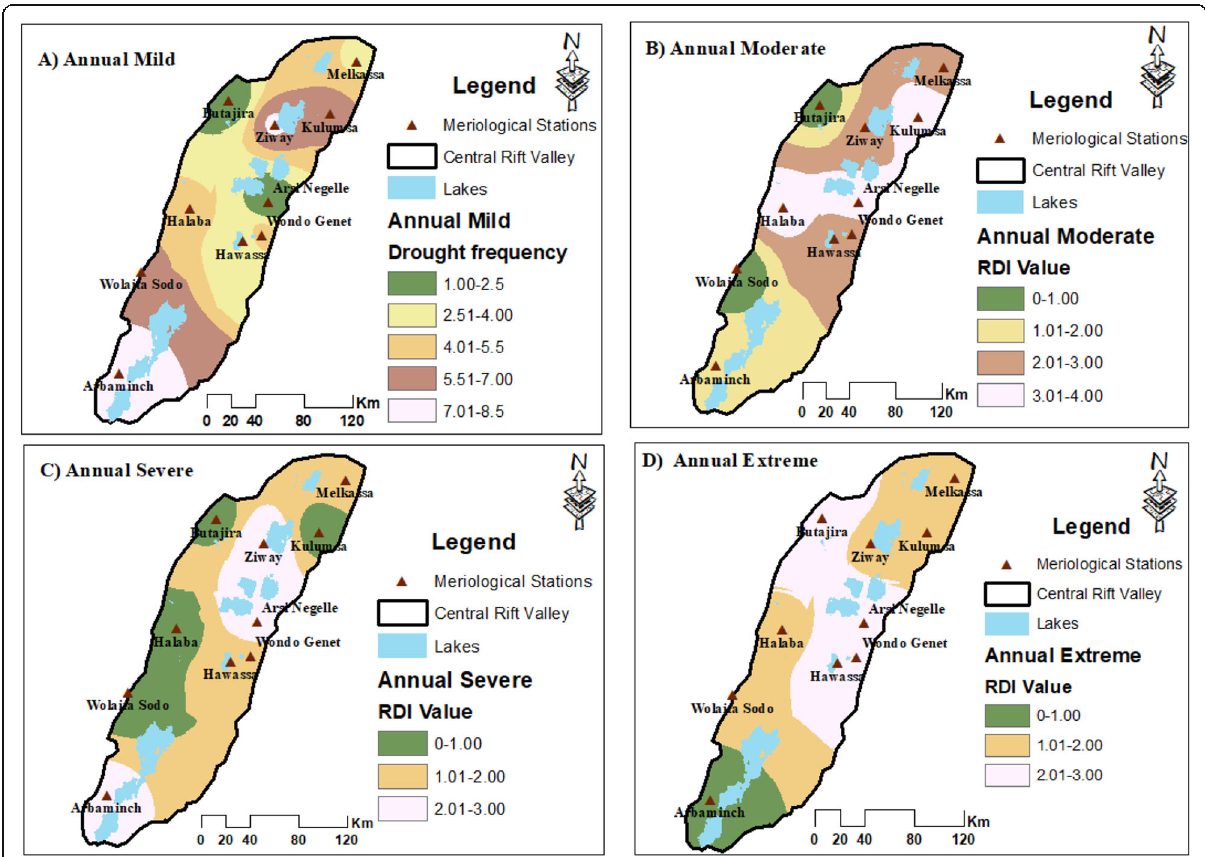
Fig. 9 Spatial distribution of drought events at annual time scale in LRERV of Ethiopia: a mild drought, b moderate drought, c severe drought, d extreme